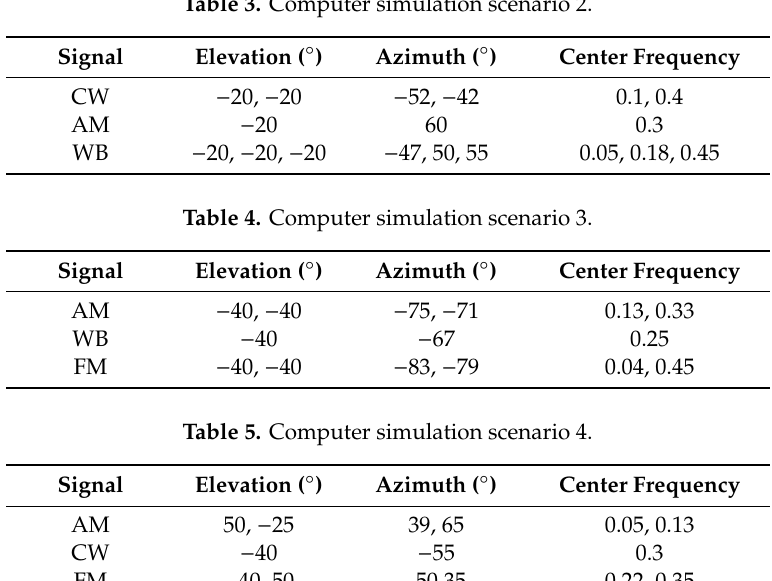
Table 3. Computer simulation scenario 2.